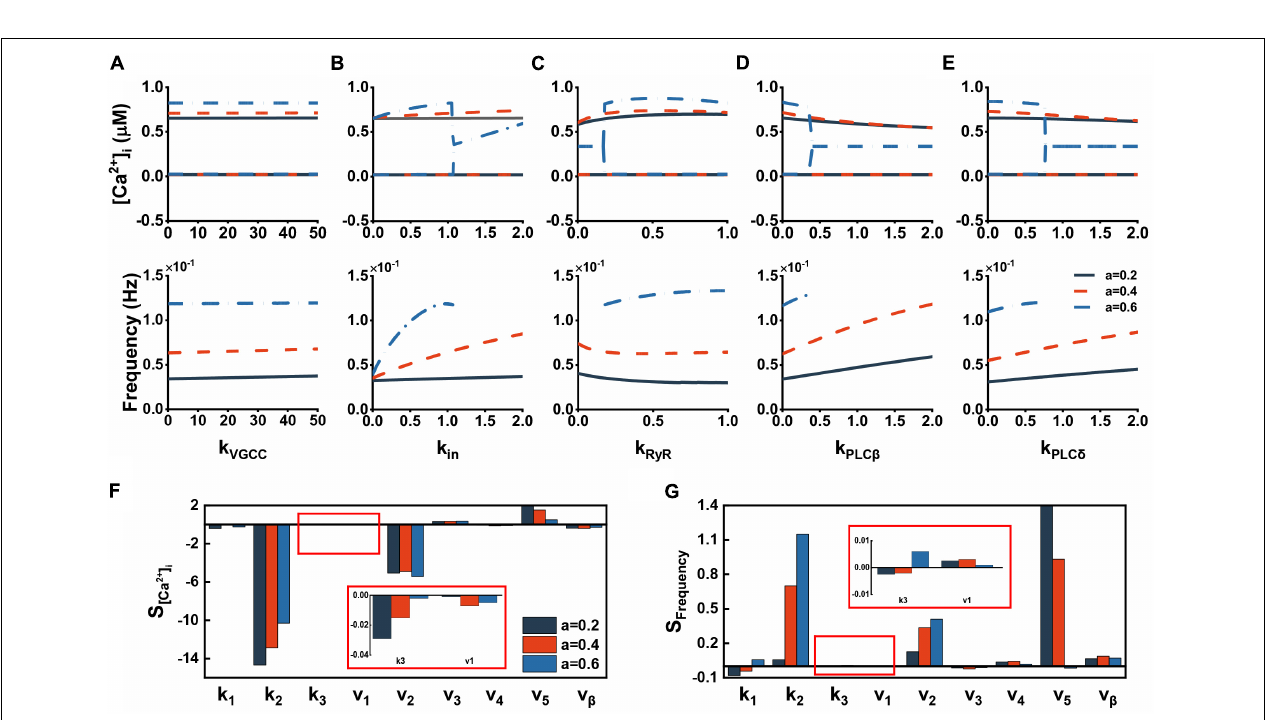
FIGURE 2 | The effect of A β on cytosolic Ca 2 + dynamics. (A) The time course of Ca 2 + dynamics at different A β levels (0, 0.2, 0.4, 0.6, and 0.8). (B) Bifurcation diagram of [Ca 2 + ] i plotted against the A β level, a . (C) The frequency of Ca 2 + oscillations plotted against the A β level, a .